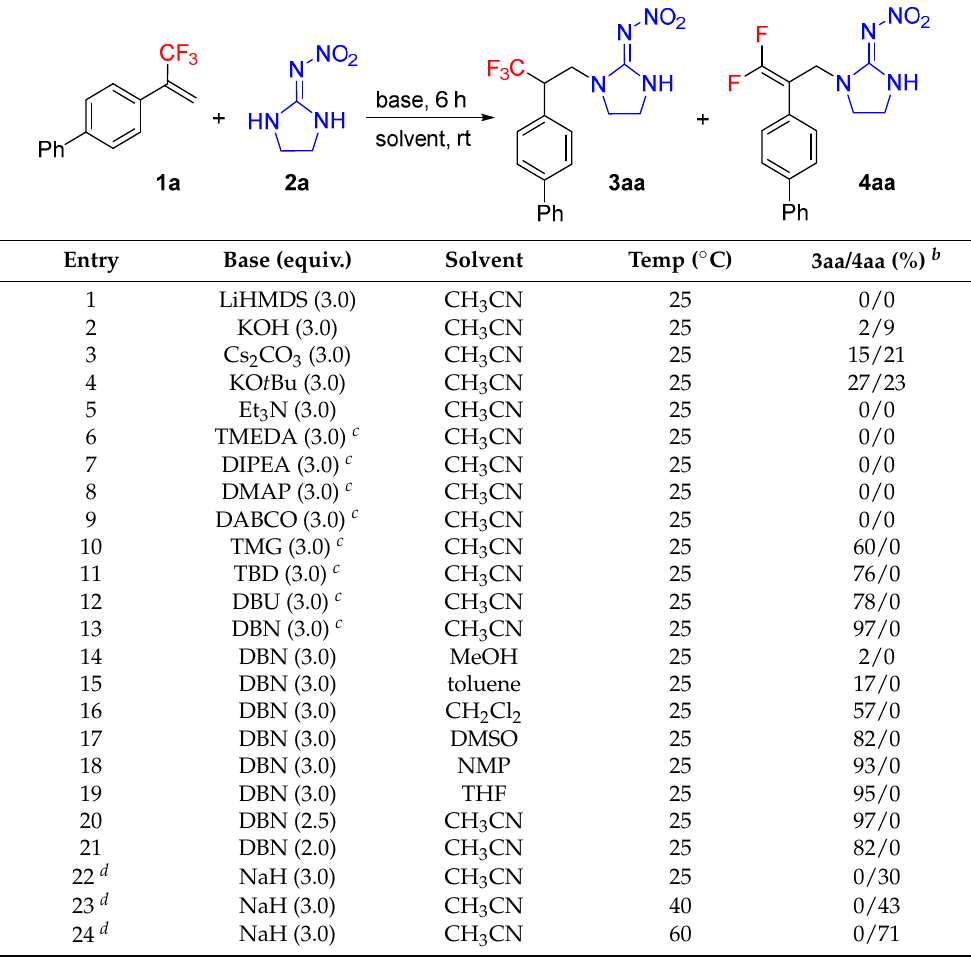
Table 1. Optimization of reaction conditions a .